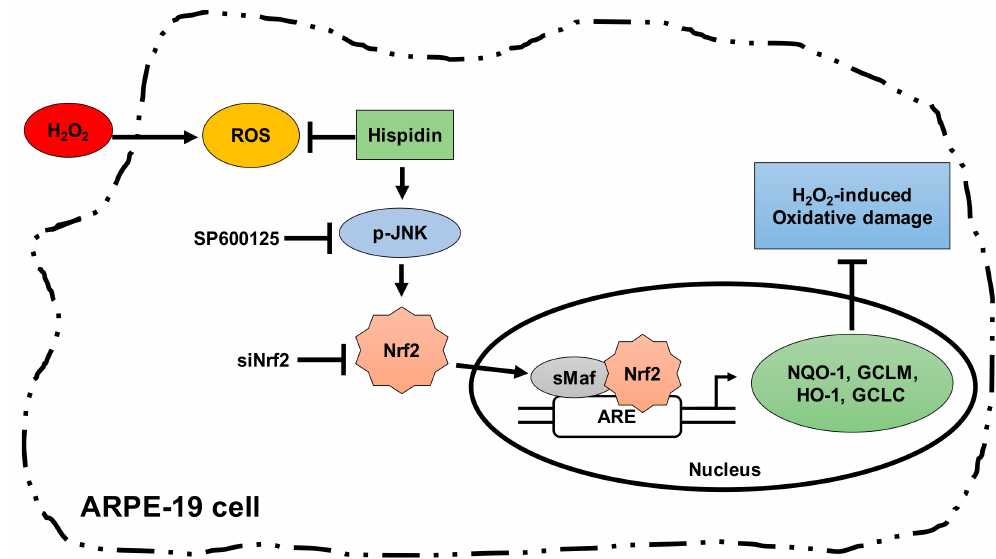
Figure 6. Schematic representation a proposed pathway for hispidin-induced Nrf2 / ARE-mediated cytoprotective proteins. Up-regulation of Nrf2 target genes such as HO-1 explains the protective e ff ects against H 2 O 2 -induced oxidative stress in ARPE-19 cells. ARE: Antioxidant response elements; sMaf: Small Maf (musculoaponeurotic